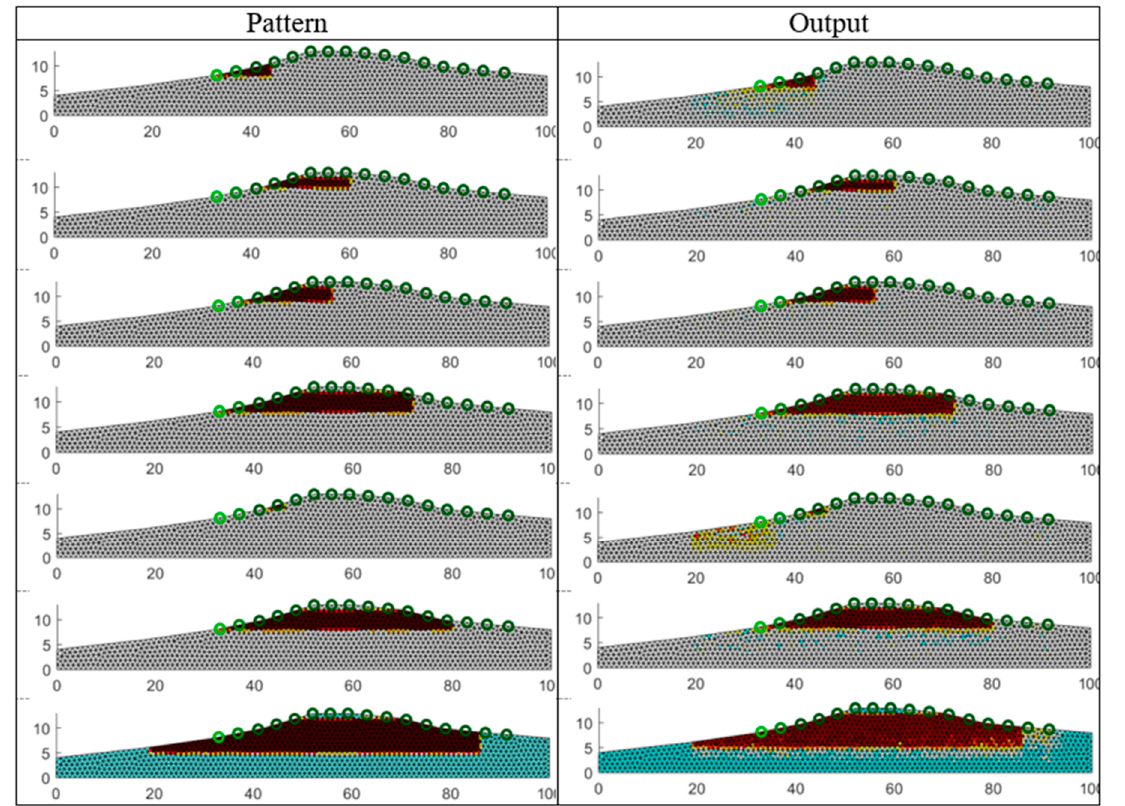
Figure 16. Comparison of patterns and outputs.